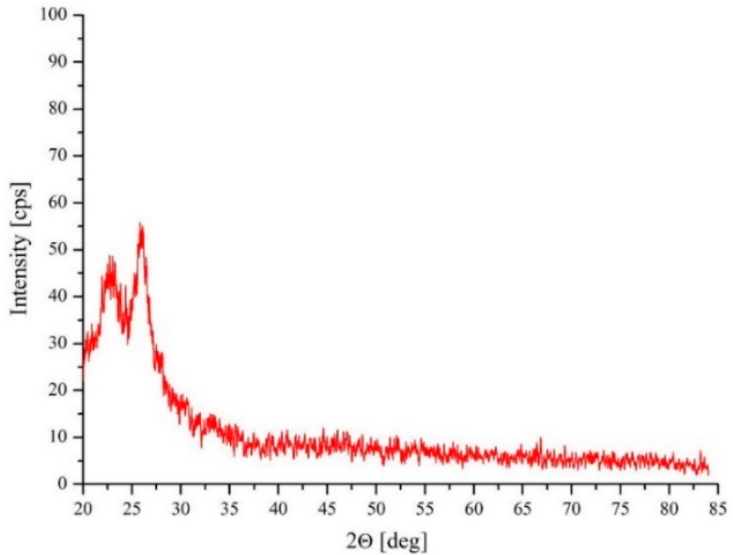
Figure 8. The X-ray diffractometer (XRD) spectra of the isothermally annealed samples.